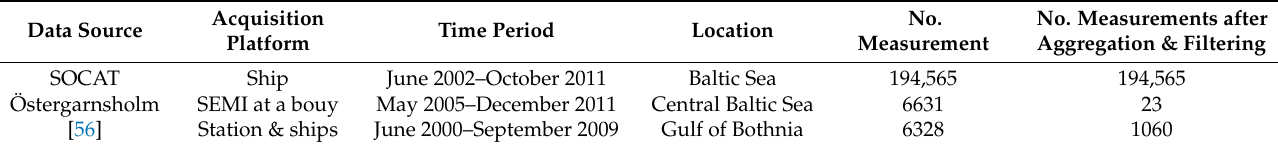
Table 2. The in-situ measurements used in this